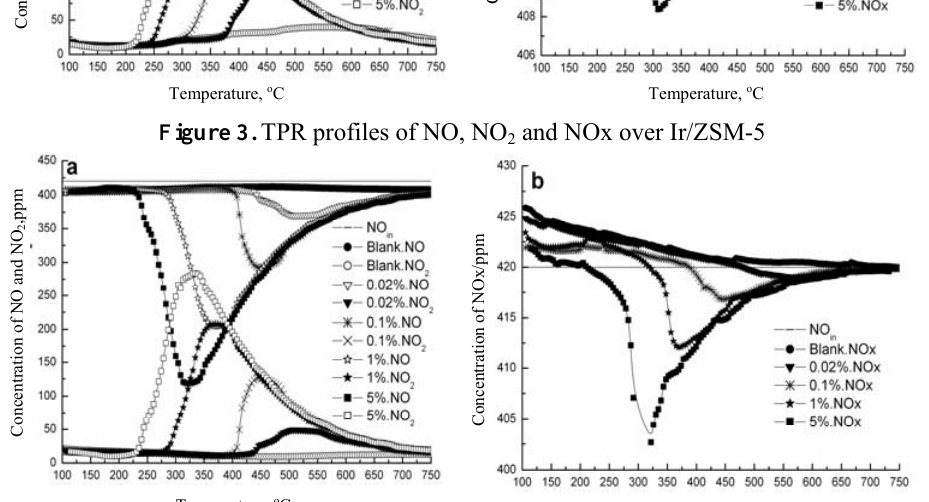
Figure 4. TPR profiles of NO, NO